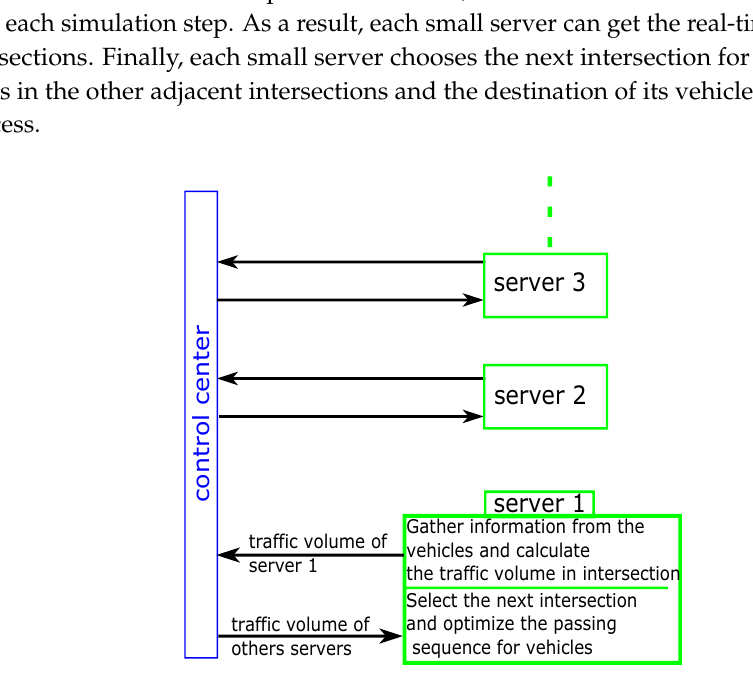
Figure 7. The exchange of information between the network and